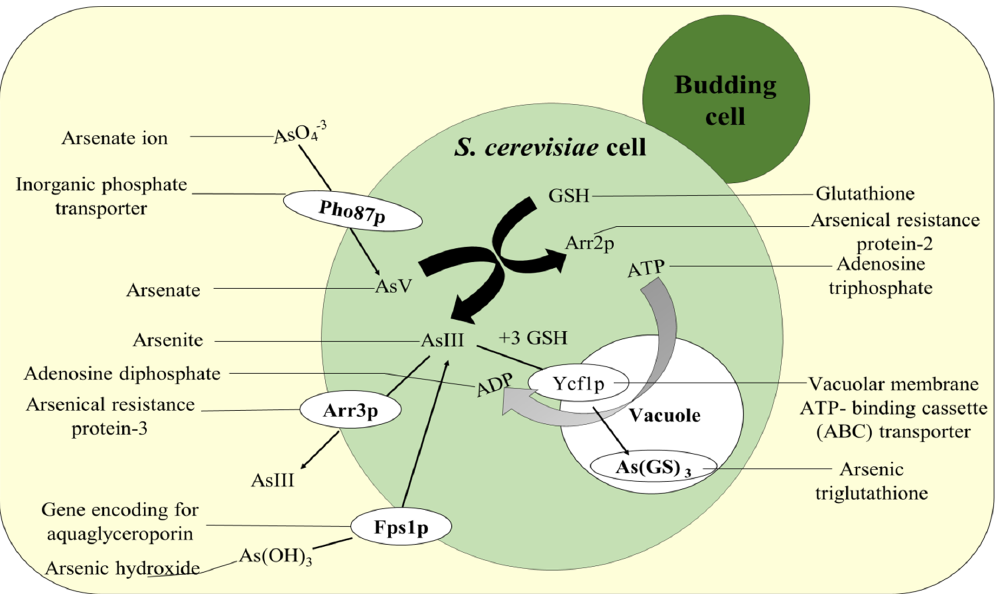
Figure 5. Arsenic detoxification mechanism used by Saccharomyces cerevisiae . In S. cerevisiae , AsIII and AsV are transported by the cytoplasmic arsenate reductases ArsC and Arr2p. Arr3p is a potential- driven arsenite efflux protein that combines with ArsA to produce an ATPase (in bacteria). Several glycerol proteins (GP) also transport arsenite, including GlpF and Fps1p . PHO87p is an uptake transporter that transports phosphates (and arsenates). In yeast cells, Ycf1p is a transporter of As(III)-3 GSH adducts into the cellular vacuole compartment, which functions as an ATPase. GSH—